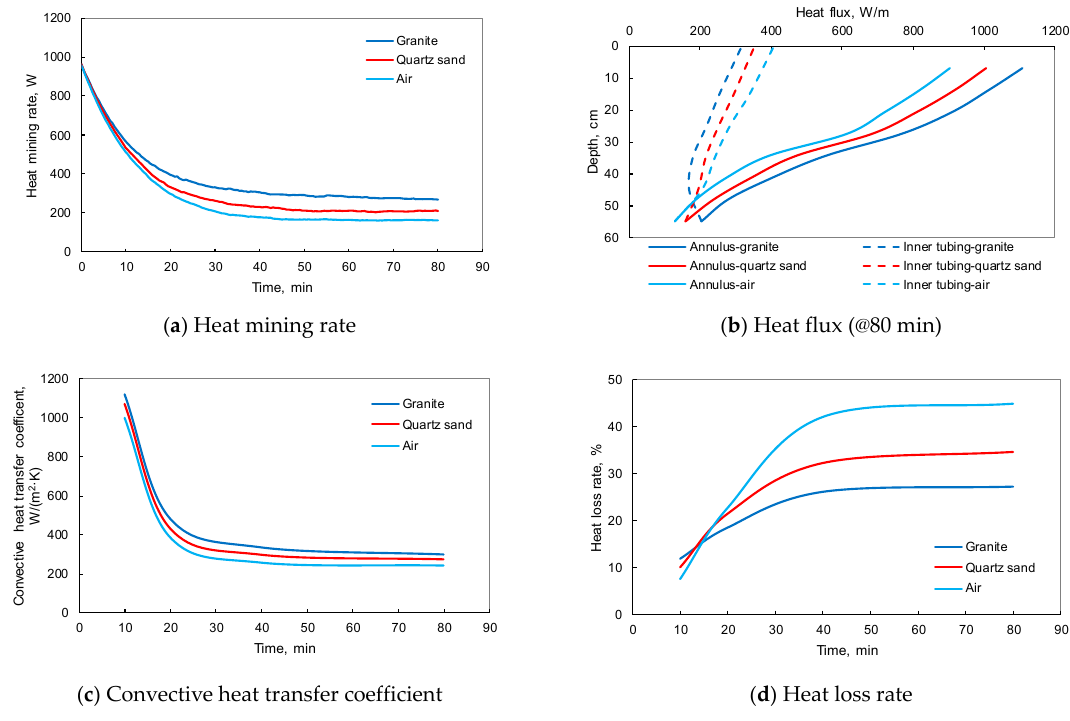
Figure 10. The main heat exchange parameters under different reservoir types.